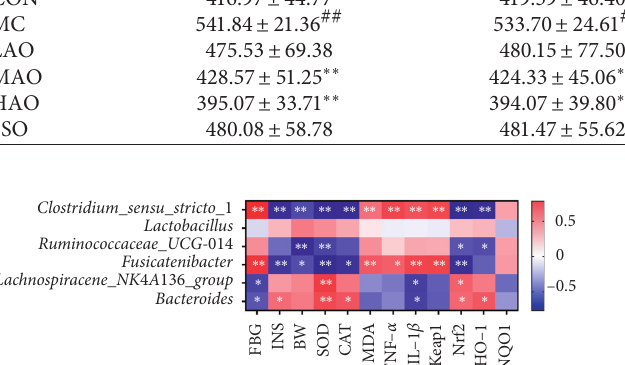
Figure 11: Significant correlation between the abundance of bacteria genus and metabolic parameters was selected using Spearman correlation analysis ( ∗ P < 0 . 05, ∗∗ P < 0 .